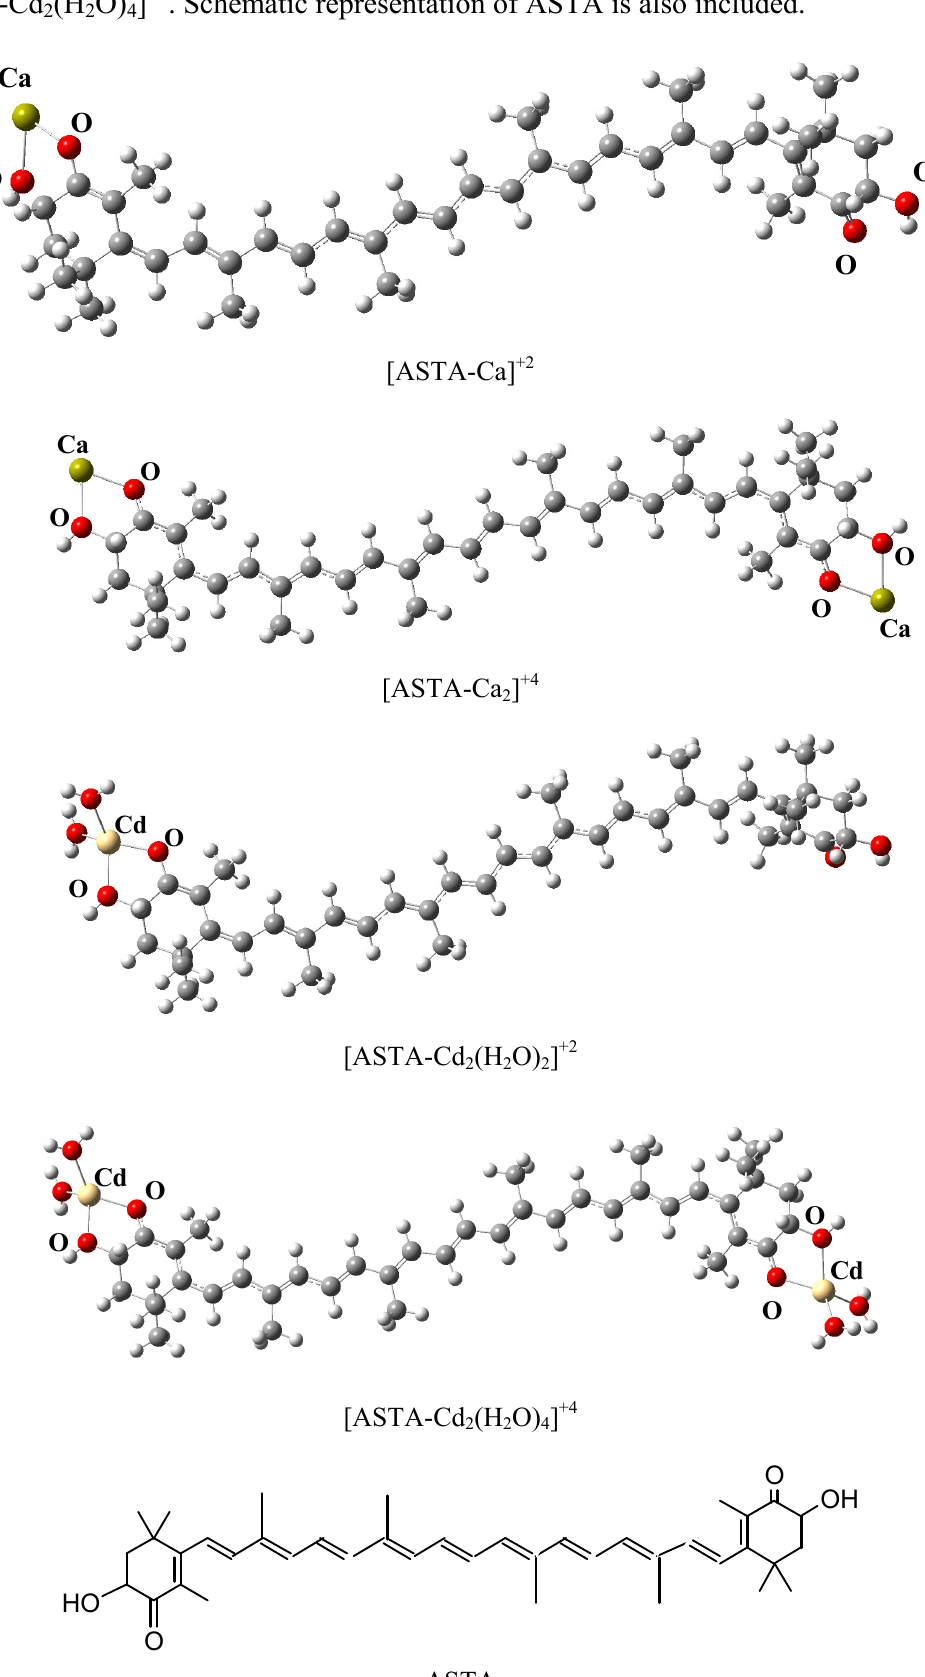
Figure 2. Optimized structures of [ASTA-Ca] +2 , [ASTA-Ca [ASTA-Cd